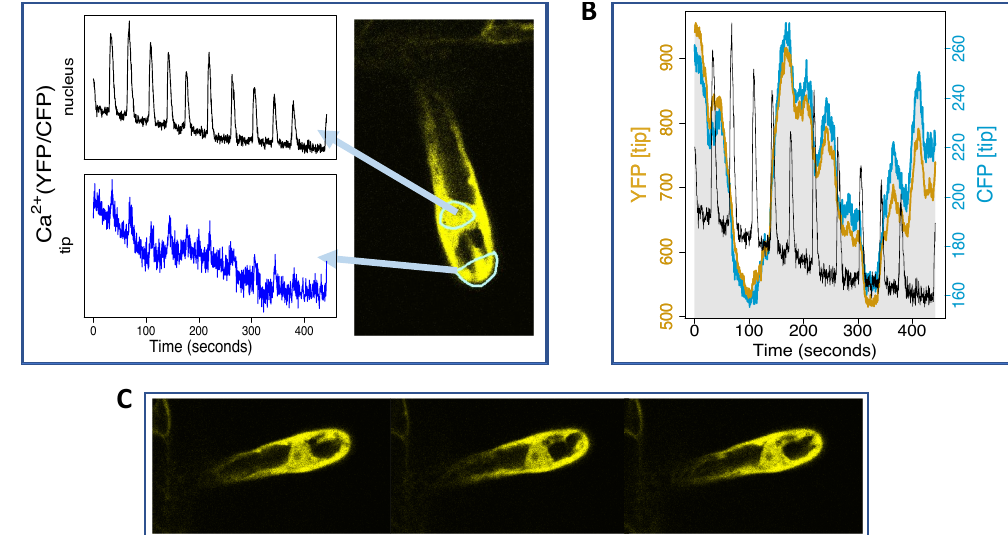
Figure 8. Is the Ca 2 + signature related to cytoplasmic streaming? Panel ( A ) shows perinuclear and apical Ca 2 + spikes, corresponding to the statically-defined regions shown in the YFP signal. Panel ( B ) shows that perinuclear Ca 2 + spiking occurs when there is a parallel change in the YFP (gold colour) and CFP (cyan) intensities at the tip region. Examples of how the appearance of cytoplasm at the tip changes are seen by comparing Panels ( A , C ), which show the YFP images at different times. For the time series in Panels ( A , B ), time points were taken every 0.44 s. The Ca 2 + sensor was the cytosolic/nuclear-localised